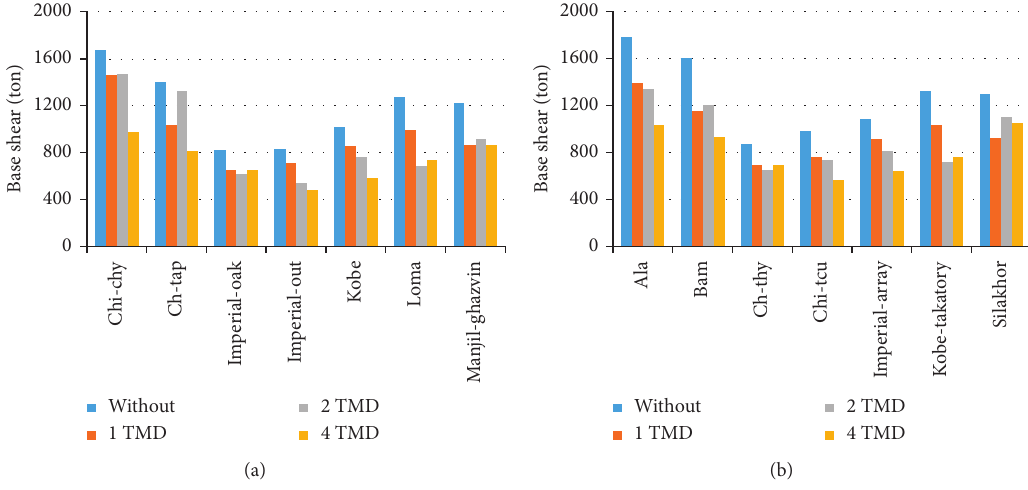
Figure 12: Base shear under the near-field (right) and far-field (left) earthquakes in the regular 10-story